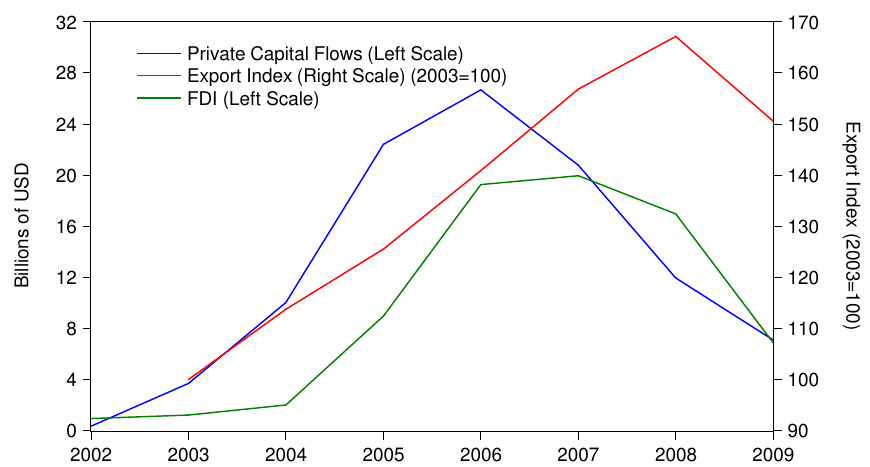
Figure 5. FDI and Private Capital Flows vs.